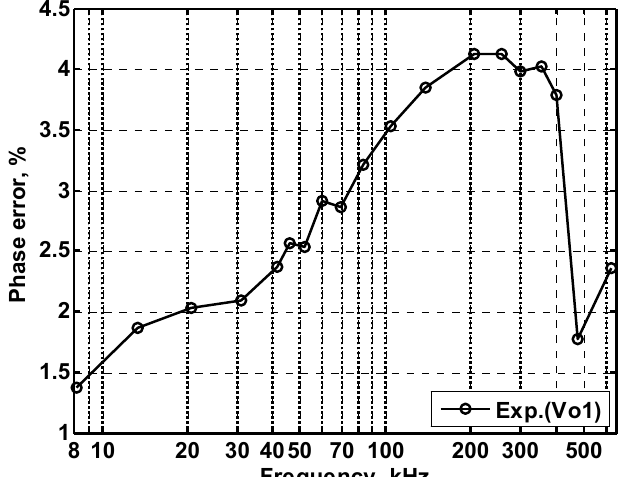
Figure 22. The measured phase error of oscillation frequency.